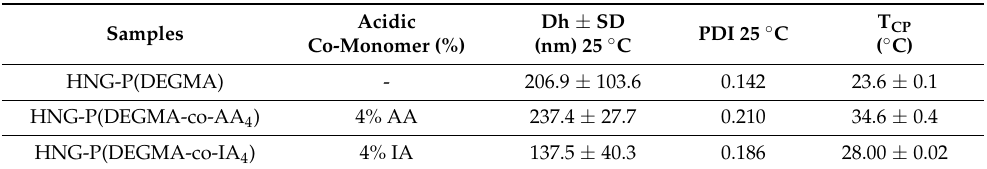
Table 3. HNGs synthesized HNGs synthesized starting from constant amount of MSN@MEMO and DEGMA with/without AA and